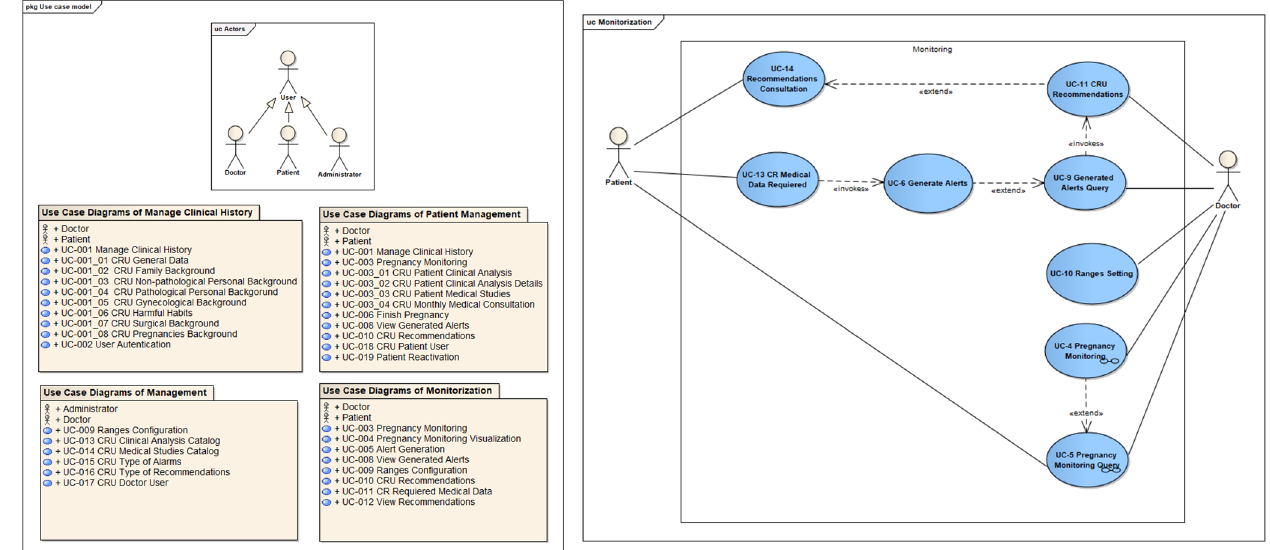
Figure 1. Package diagram of use cases ( left ) and use case diagram for monitoring ( right ).